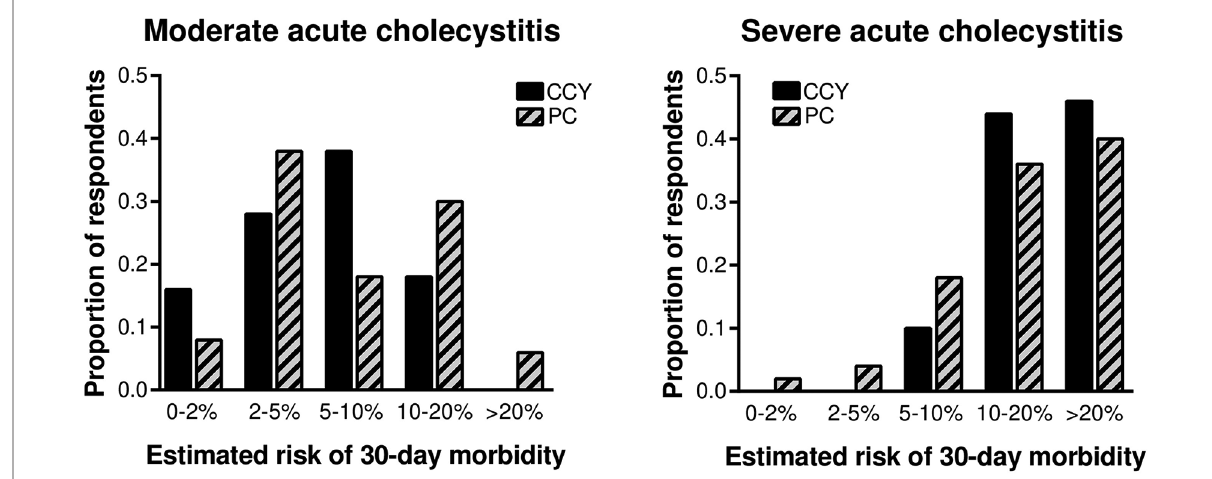
FIGURE 1 Surgeon-estimated 30-day morbidity was similar for laparoscopic cholecystectomy and percutaneous cholecystostomy for both moderate and severe cholecystitis. CCY, laparoscopic cholecystectomy; PC, percutaneous cholecystostomy.